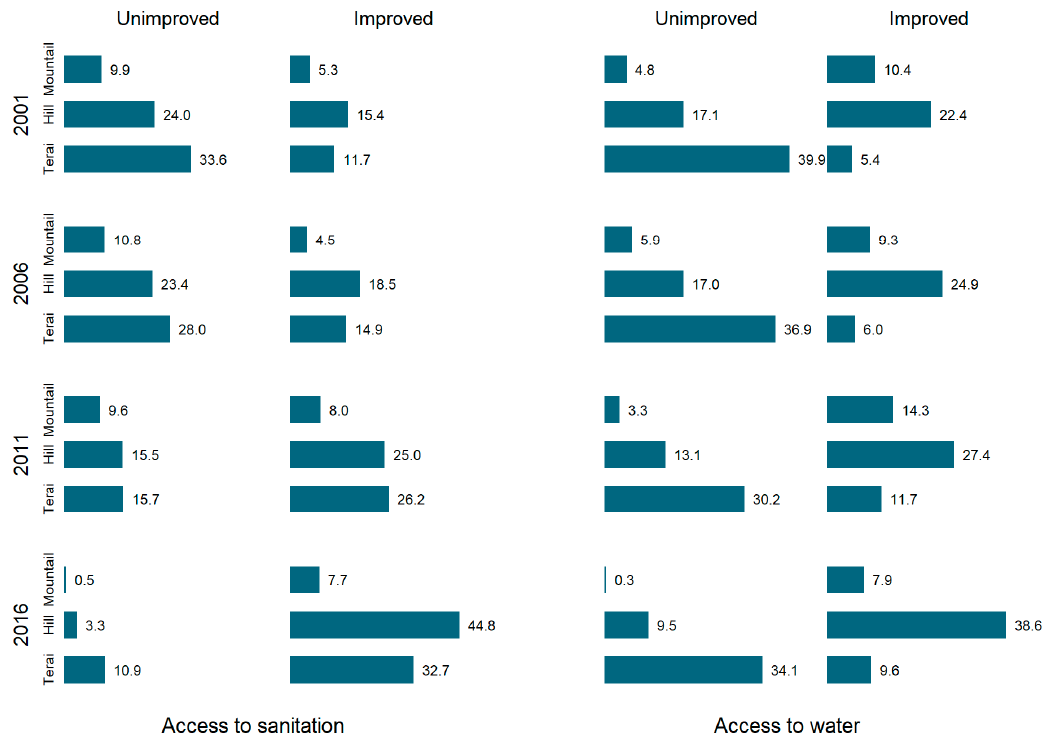
Figure 6. Trend in inequality in improved water and sanitation coverage across three ecological zones.